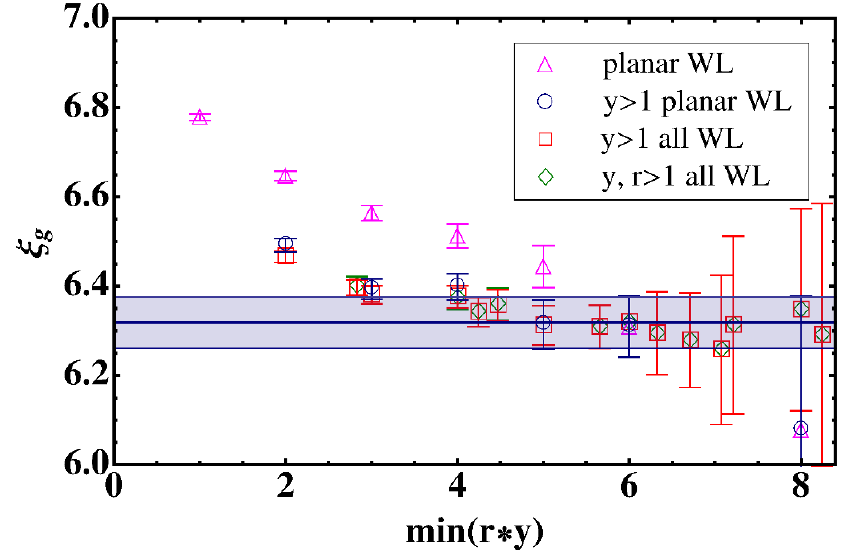
Figure 3 . Gauge anisotropy (cid:24) g extracted from the ratios of Wilson loops. Di(cid:11)erent colored points denote the values of (cid:24) g obtained by using eq. (3.9) with di(cid:11)erent sets of data for a given min( r (cid:3) y ), while the blue band denotes the extracted value of (cid:24) g . Details are found in the main body of the